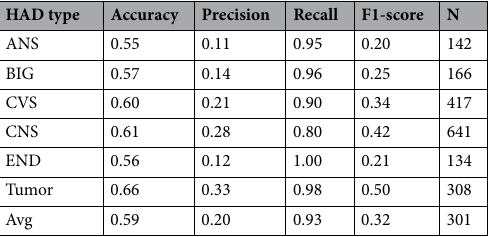
Table 15. Prediction performance on each HAD type in IPD data set.